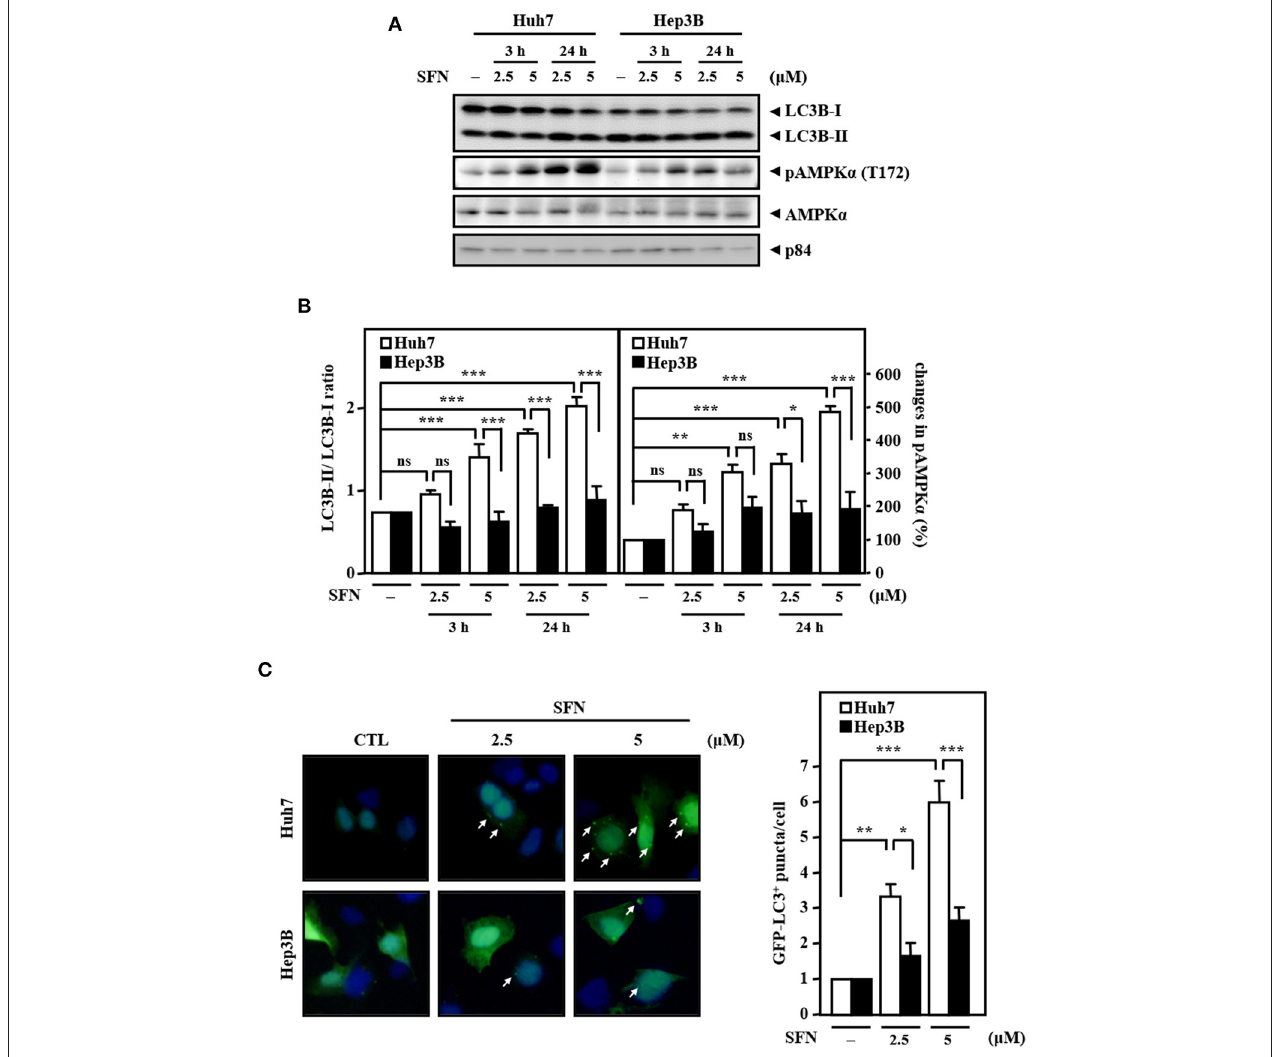
FIGURE 3 | Resistance of Hep3B cells to sorafenib is associated with lower autophagic responsiveness. (A) Huh7 and Hep3B cells were treated with sorafenib at the indicated concentrations for 3 and 24h. Whole cell lysates were harvested for Western blot analyses. (B) The quantitative analyses of phosphorylated AMPK and LC3B-II/LC3B-I were shown in the graphs. (C) Huh7 and Hep3B cells were transfected with GFP-LC3B expression vectors and then treated with sorafenib at the indicated concentrations for 6h. The number of LC3B puncta was evaluated under a fluorescence microscope. The data are shown as the mean ± SD. * P < 0.05; ** P < 0.01; *** P < 0.001 by Student’s t